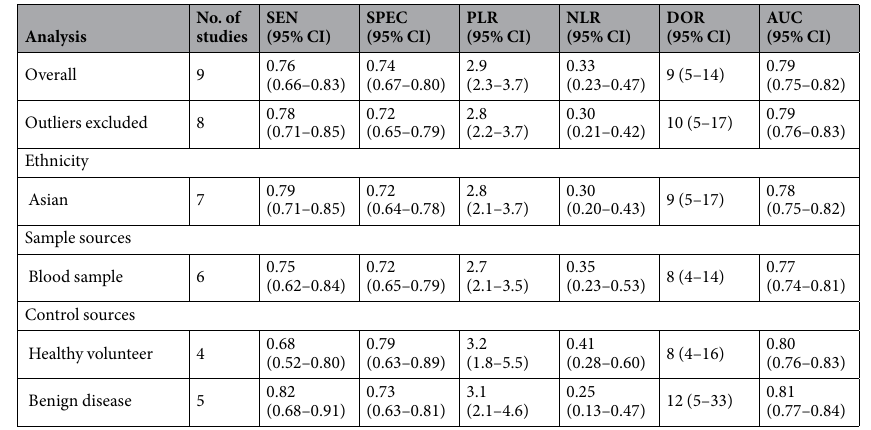
Table 2. Summary estimates of diagnostic test for circulating hsa-miR-21-5p in PC patients. SEN, sensitivity; SPEC, specificity; PLR, positive likelihood ratio; NLR, positive likelihood ratio; DOR, diagnostic odds ratio; AUC, area under the ROC curve.